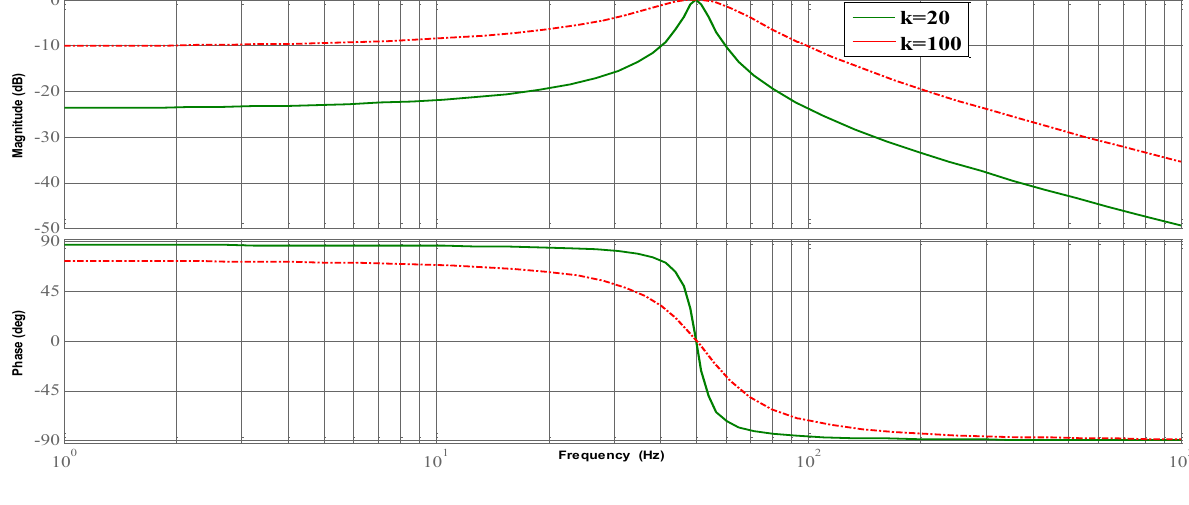
Fig.3: bode Figure 7. Bode plot of HSF filter.